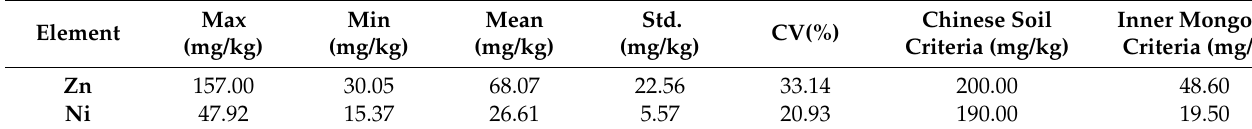
Table 1. Descriptive statistics for heavy metal concentrations in the study area.